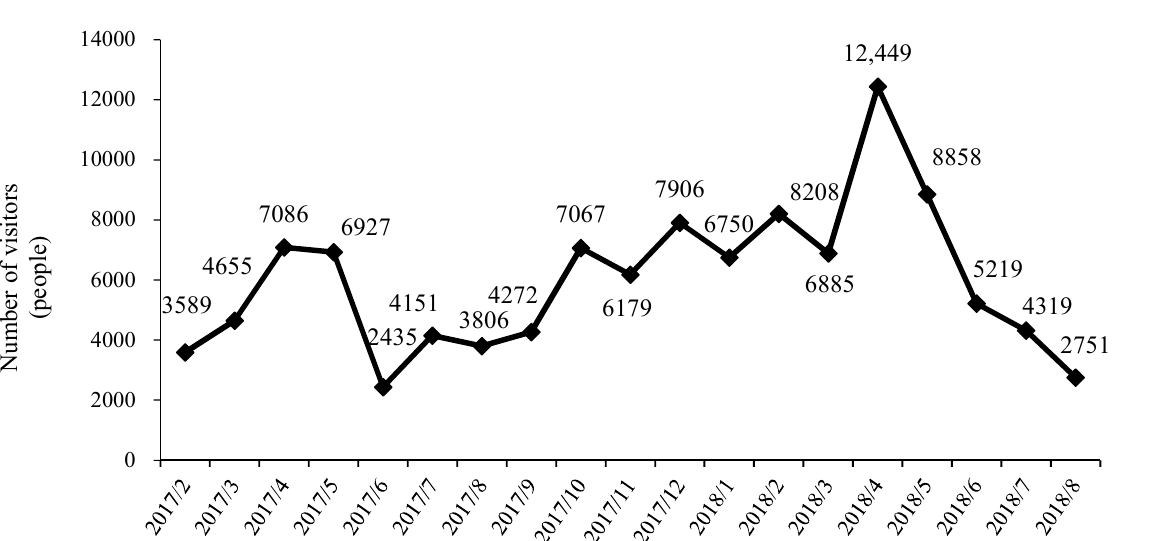
Figure 3. Monthly visitors to the Sinhua Forest Park Source: Sinhua Forest Park [29].